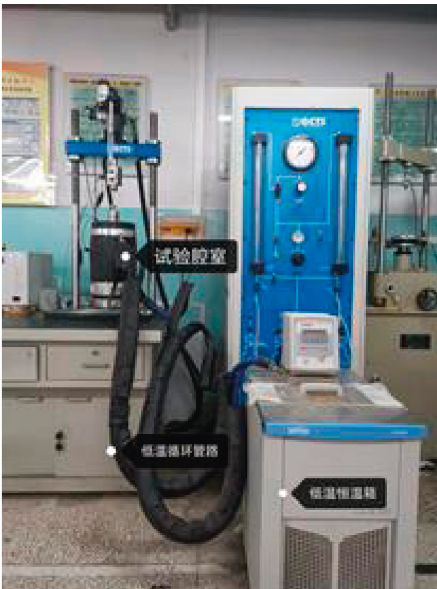
Figure 1: The STX-100 dynamic triaxial tester.